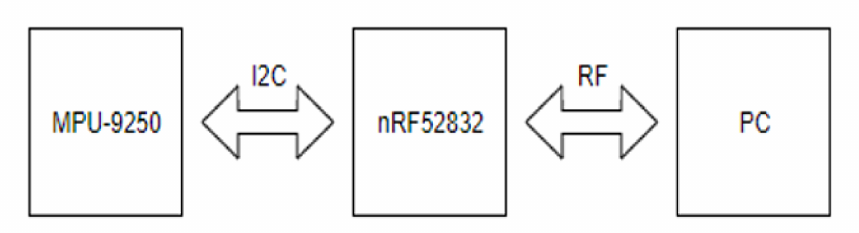
Figure 1. Data collection